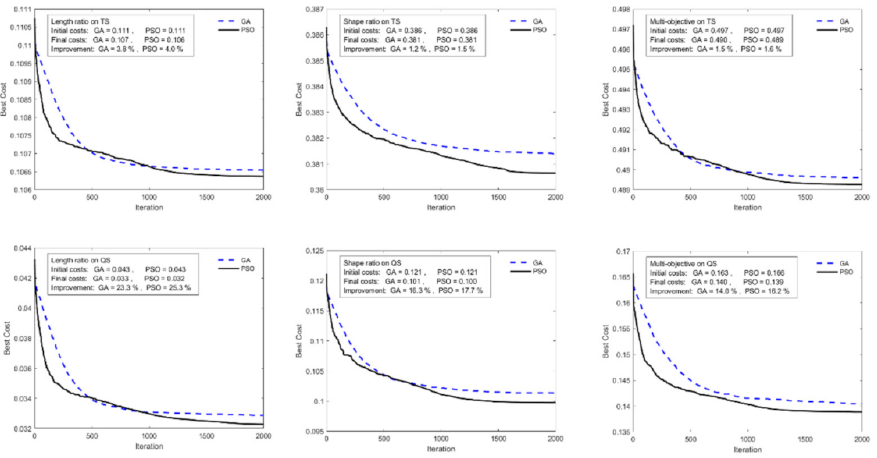
Figure 4. The PSO and GA diagrams on Sinusoidal gridshell considering different cost functions.